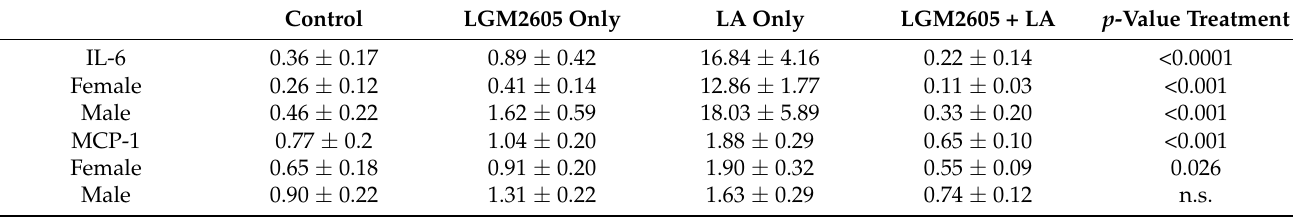
Figure 7. Detection of immunoglobulin isotypes in PLF via cytometry bead array. LA treatment significantly decreased the relative concentrations of IgG1 (* p = 0.032) and IgG2b (** p < 0.01) compared to saline control; LGM2605 + LA treatment significantly increased the concentrations of IgG1 (## p < 0.01) and IgG2b (## p < 0.01) back to control levels. LA exposure also significantly increased IgA concentration compared to saline control, * p = 0.037; LGM2605 + LA treatment reduced IgA concentration back to control levels, # p = 0.025. Following two-way ANOVA, data were analyzed via Tukey post-hoc test. Table 2. PLF cytokines by cytometric bead array. Data are presented as mean concentration in pg/mL ± std error. Data were analyzed by two-way ANOVA (for overall treatment effects) and by one-way ANOVA (for treatment effects subdivided by